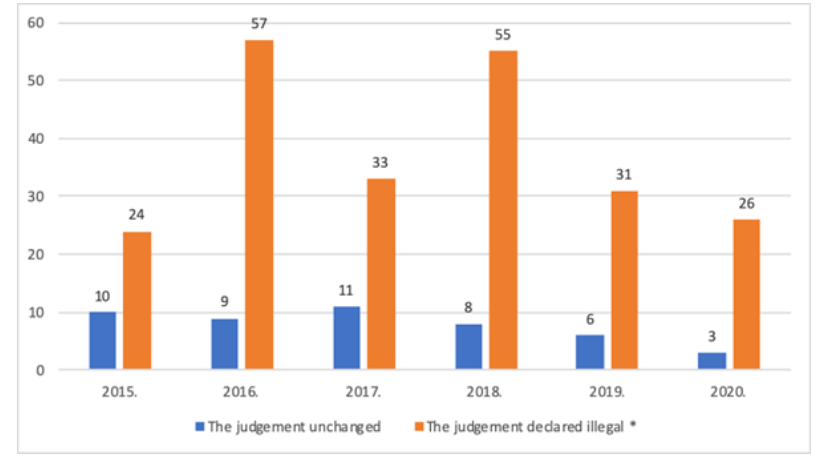
Figure 2: Rulings adopted by the Supreme Court of the Republic of Latvia in accordance with Chapter 63 of the Criminal Procedure Law [Designed by the author based on data retrieved from: Republic of Latvia Supreme Court, Archive of case-law decisions; 30 Republic of Latvia Supreme Court, Division of Case-law and Research, 2020, Nr.40-1/11-921nos 31 ] * “ The judgement declared illegal ” – When reviewing the criminal case in accordance with Chapter 63 of the Criminal Procedure Law, the Supreme Court annulled the ruling in full or in part, amended the ruling, terminated the proceedings or addressed the case to a lower